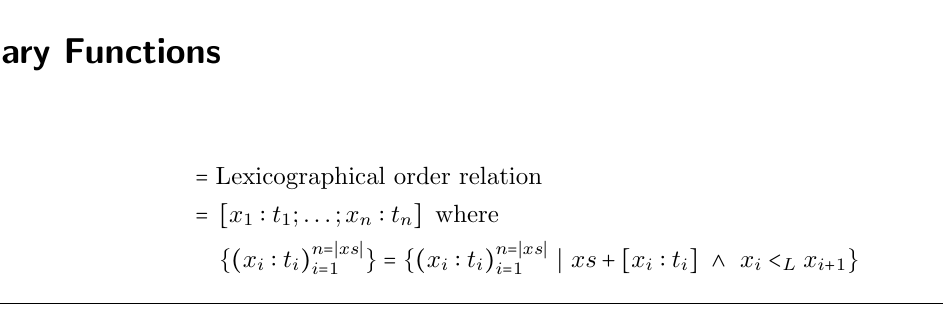
Figure 13: Lexicographical order relation and function SortList—Auxiliary relation and function for arranging node input or output arguments in alphabetical order. The elements of the list xs have the structure name ∶ type . They are sorted by a suitable lexicographical order relation on name